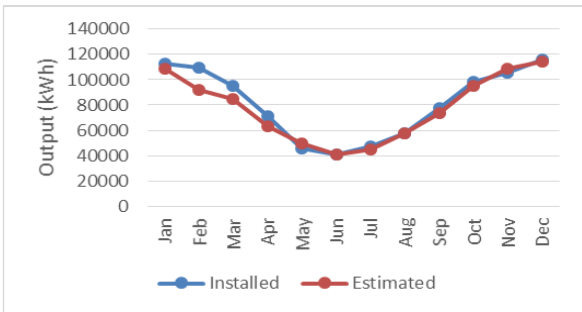
Figure 7. Monthly variation between the installed system and the estimated